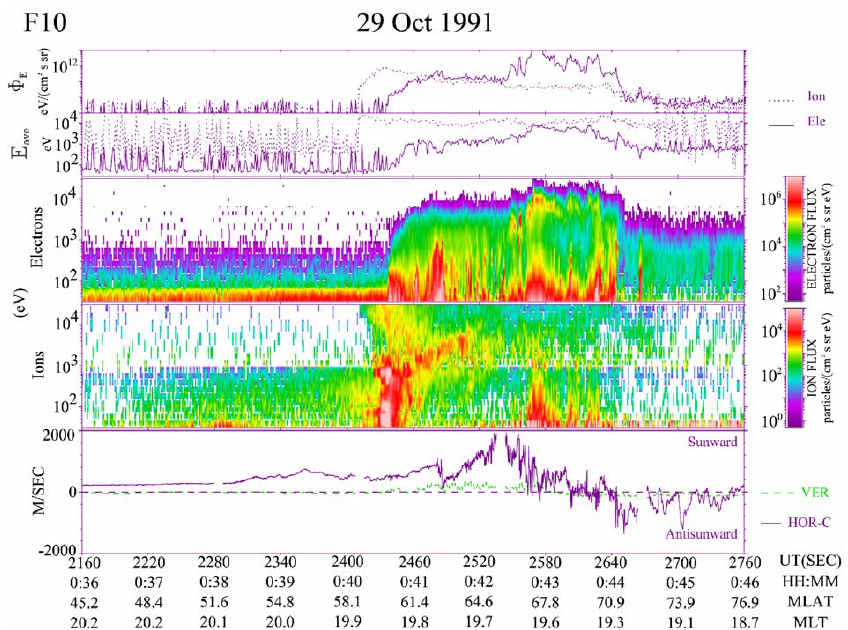
Fig. 14. DMSP data for energetic electrons and ions and bulk plasma drift along the trajectory shown in Fig. 11 at the time of the SAR arc.